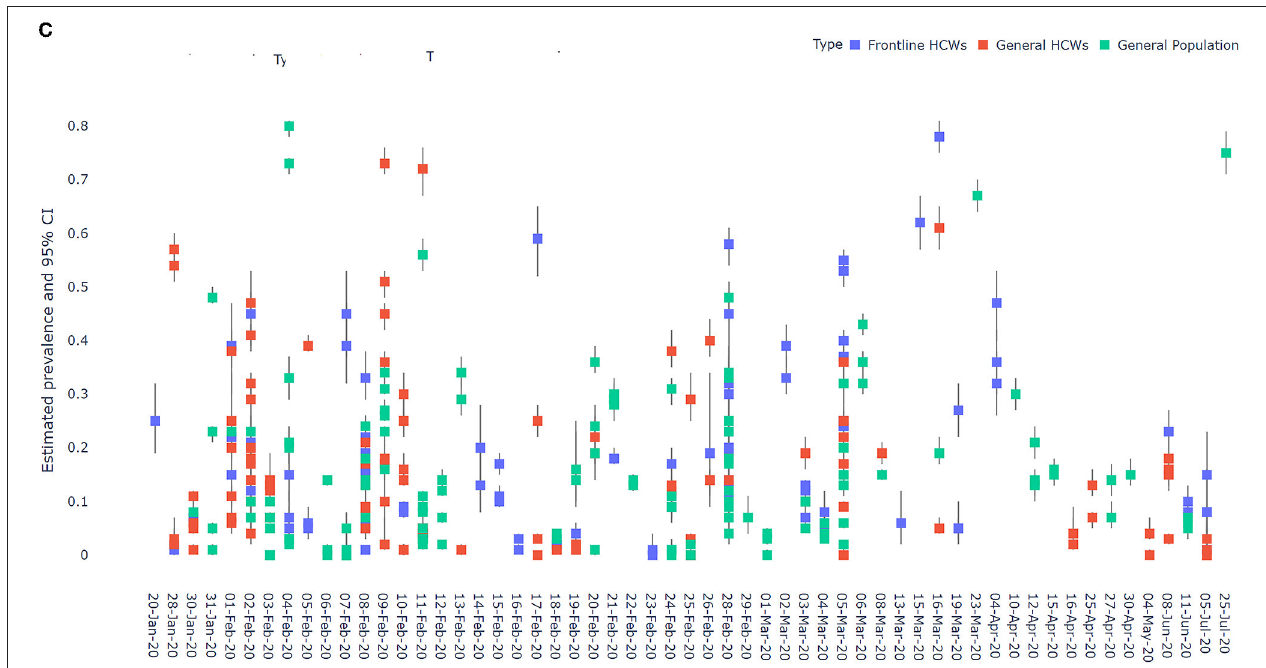
Figure 2 | (A) A forest plot of the pooled prevalence by outcomes. (B) A forest plot of the pooled prevalence by outcome levels. (C) A forest plot of the pooled prevalence by